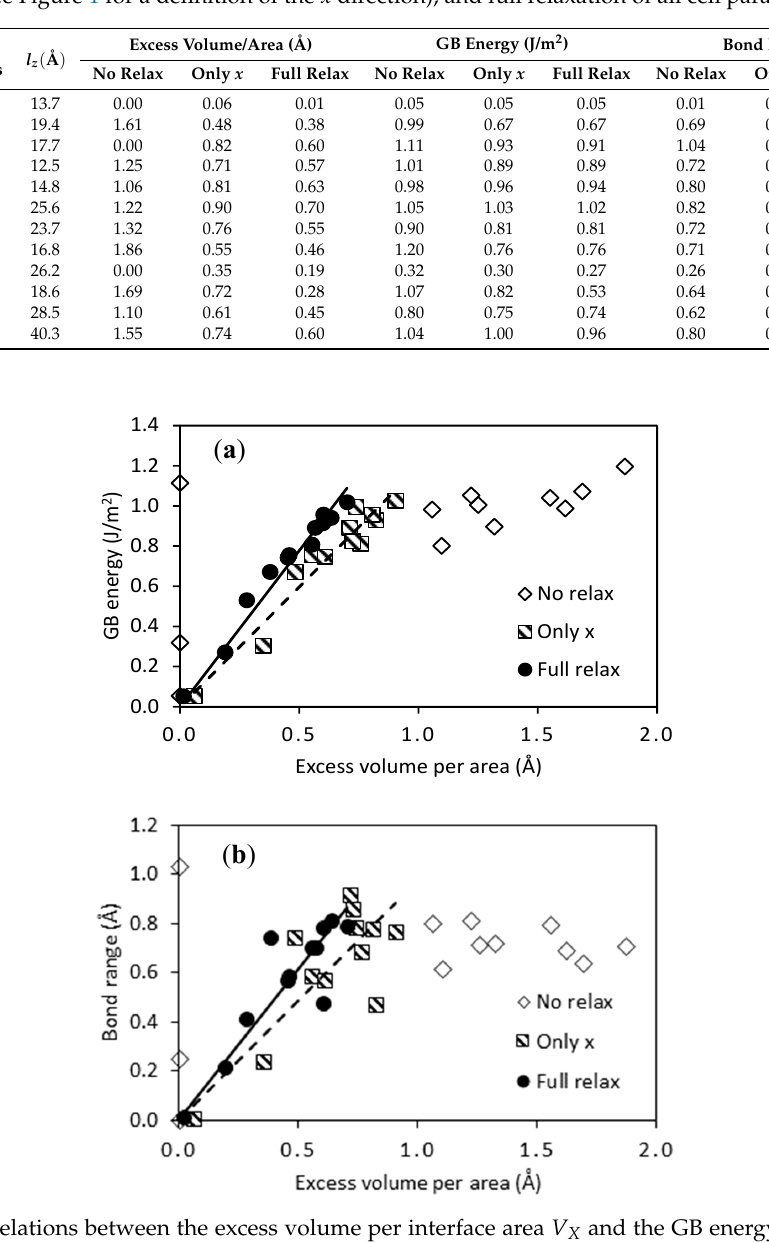
Table 1. The various grain boundary (GB) models investigated in this study, along with the number of atoms in their unit cells, the supercell size in the z direction l z (perpendicular to the figure plane in Figure 1), their excess volume divided by area V X , the calculated GB energy E GB , and the range of bond distances ∆ r b within the first coordination shell. All results are for pure Pd GBs. Three volume relaxation techniques (VRT) were used: no relaxation of the unit cell, only relaxation of the x lattice constant (see Figure 1 for a definition of the x direction), and full relaxation of all cell parameters.